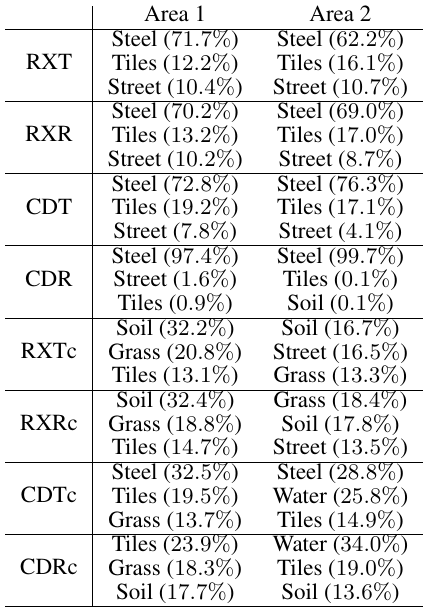
Table 2. The three most frequent classes of the detected anomalies for each detection method. Steel and Tiles refer to the roofing materials.